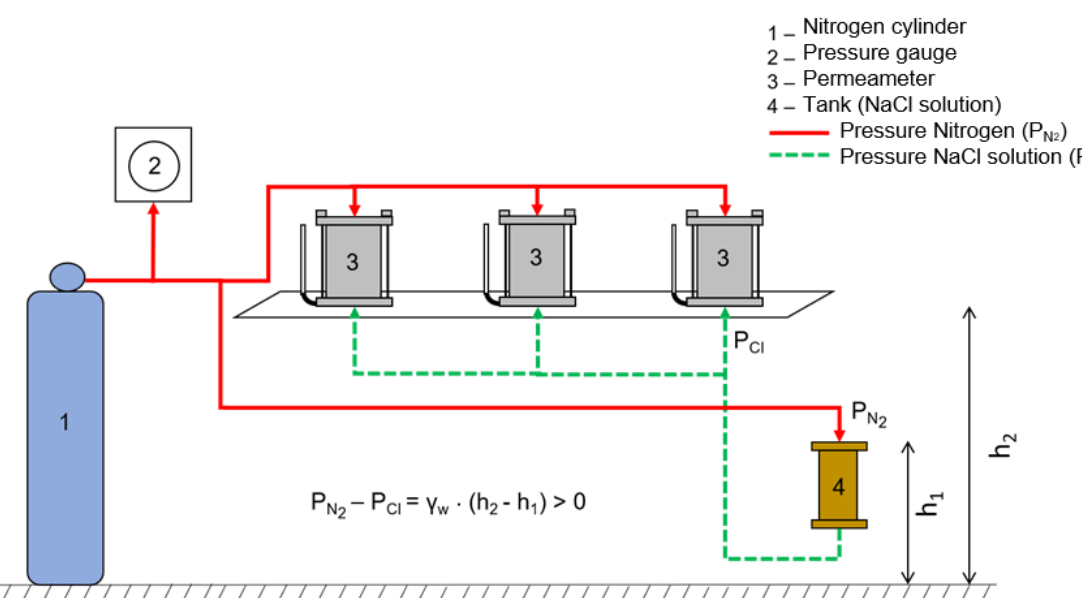
Figure 5. Schematic drawing of the column test